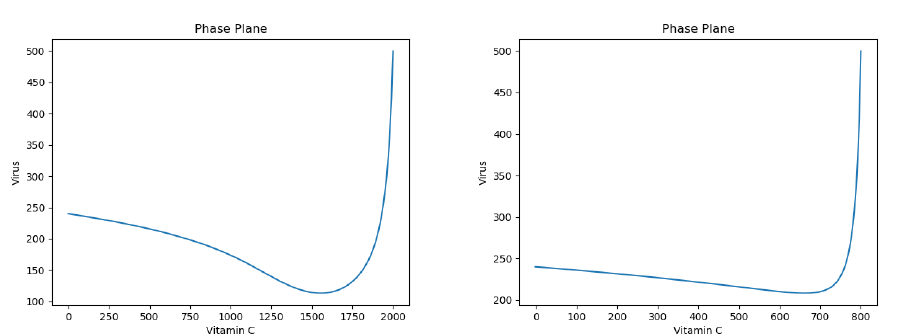
Figure 5. Phase Plane Comparison of 2000 Initial Vitamin C Dose (left) and 50 Initial Vitamin C Dose (right) under Viral